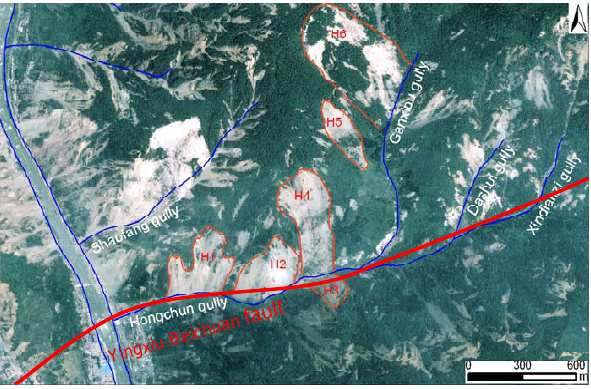
Fig. 13. Aerial photograph of the Hongchun gully debris flow and related flood (Supplied by the Sichuan geological environmental monitoring station).